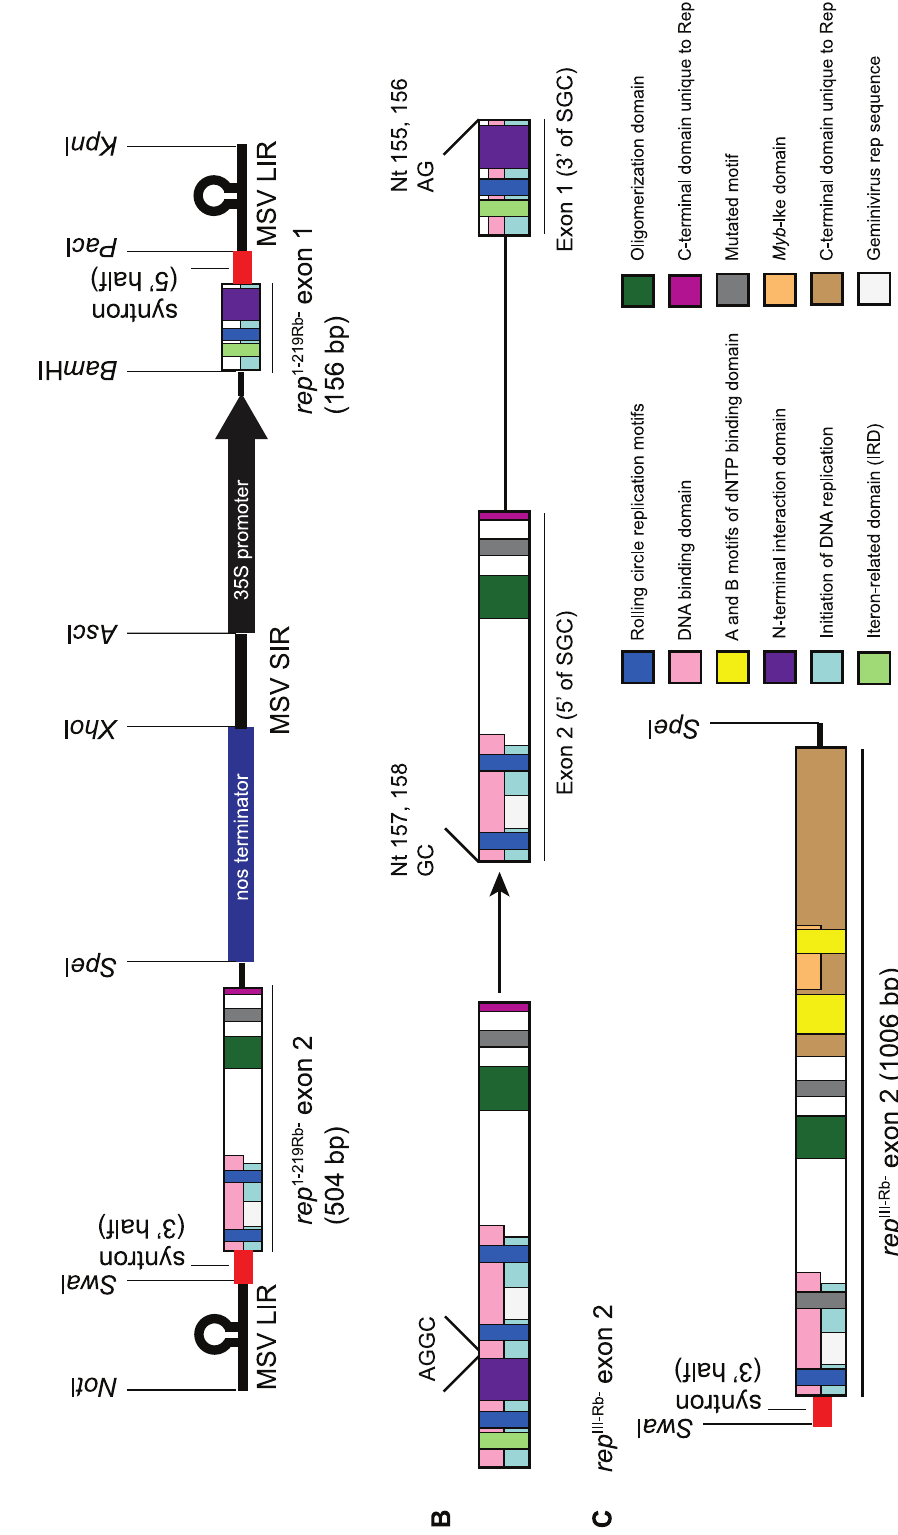
Figure 4. Schematic diagram of synthesised constructs, with restriction enzyme sites incorporated for subsequent cloning. A) pSPLIT rep 1-219Rb- 35S containing ‘‘modules’’ that could be removed and replaced with other sequences by restriction digest. B) Illustration showing how the rep 1-219Rb- transgene was split at the first AGGC (nucleotides 155, 156, 157 and 158 with respect to the start codon). The exon 2, cloned at the 5 9 terminus of the split gene cassette in A) therefore began with GC, and the exon 1, cloned at the 3 9 terminus, ended in AG. C) The synthesised